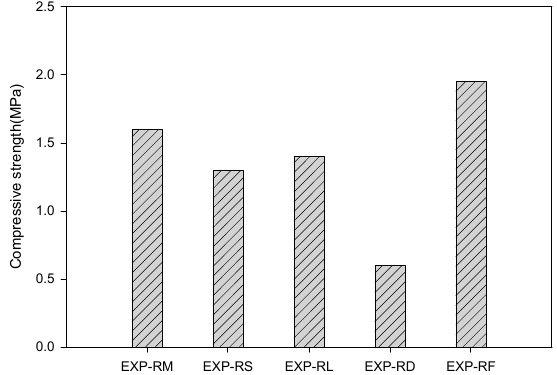
Figure 6. Compressive strength according to the type of silicate minerals.